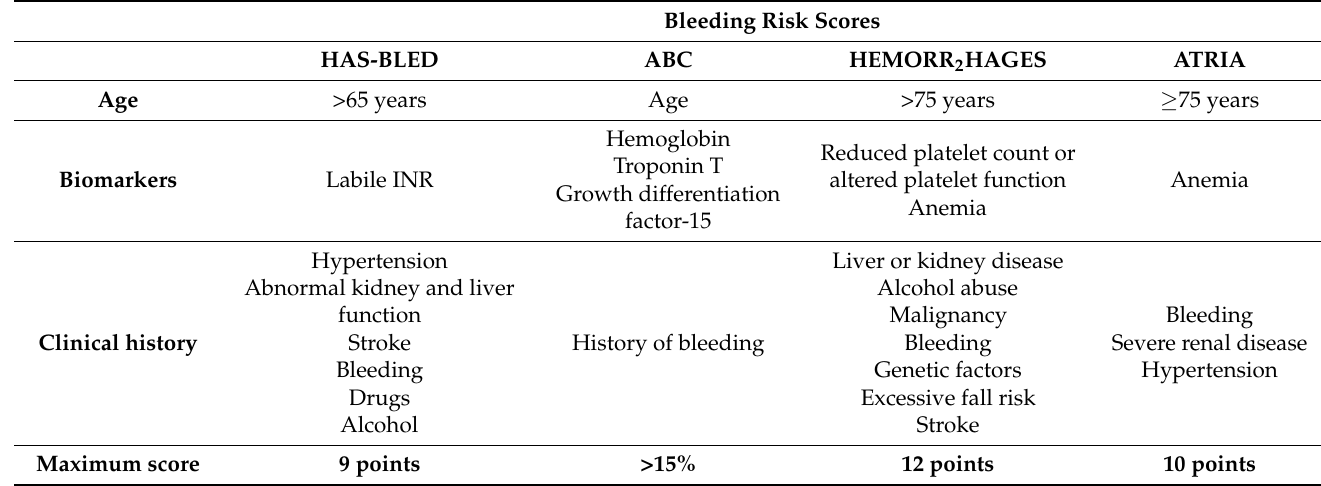
Table 1. Most common bleeding risk scores used in clinical practice for hemorrhagic risk assessment in patients with atrial fibrillation undergoing oral anticoagulation. Bleeding Risk